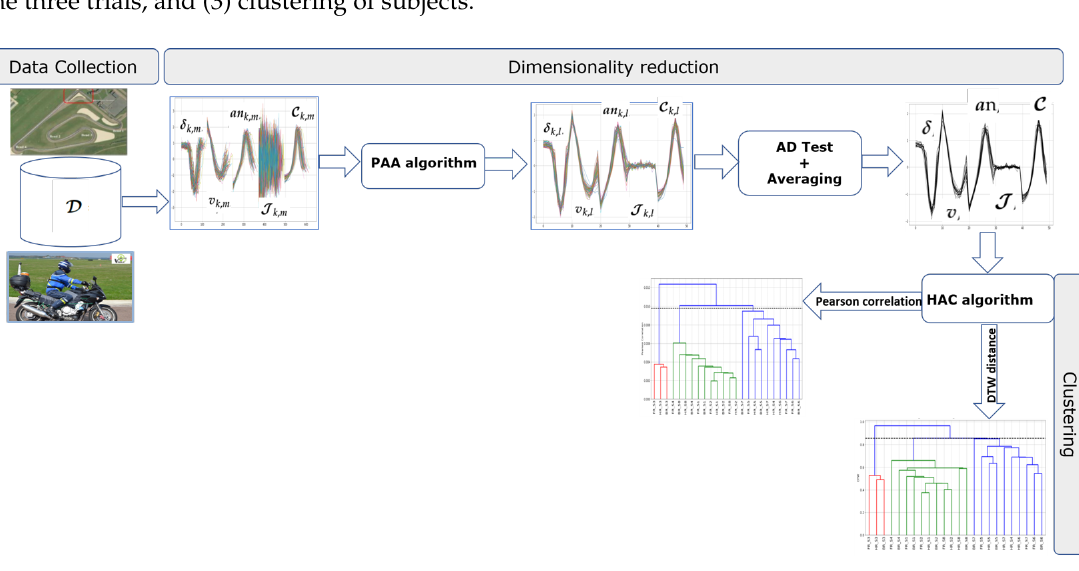
Figure 4. Overview of the clustering